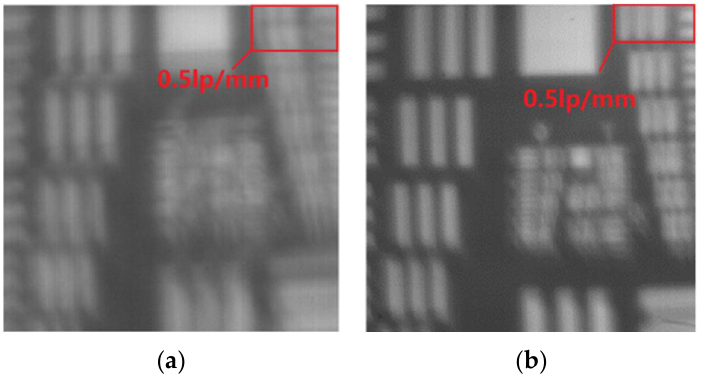
Figure 18. Results of image source experiment: ( a ) synthetic image with cophasing error; ( b ) synthetic image after correction of cophasing error.